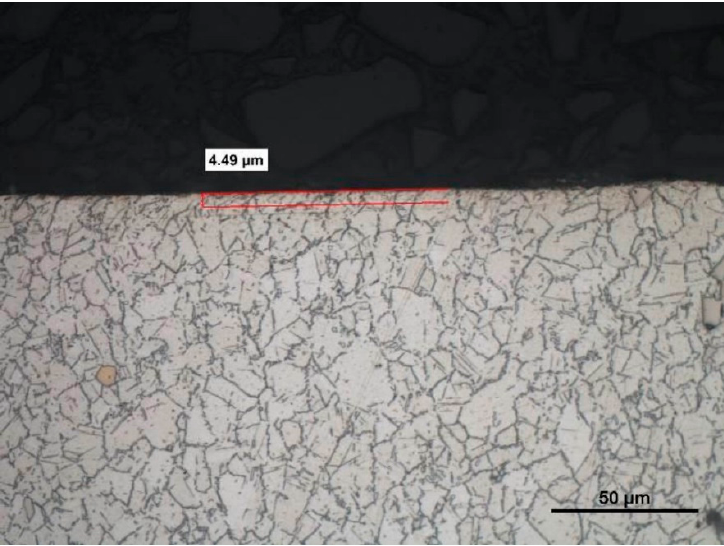
Figure 30. A view of a microsection after longitudinal turning with cooling and after etching.